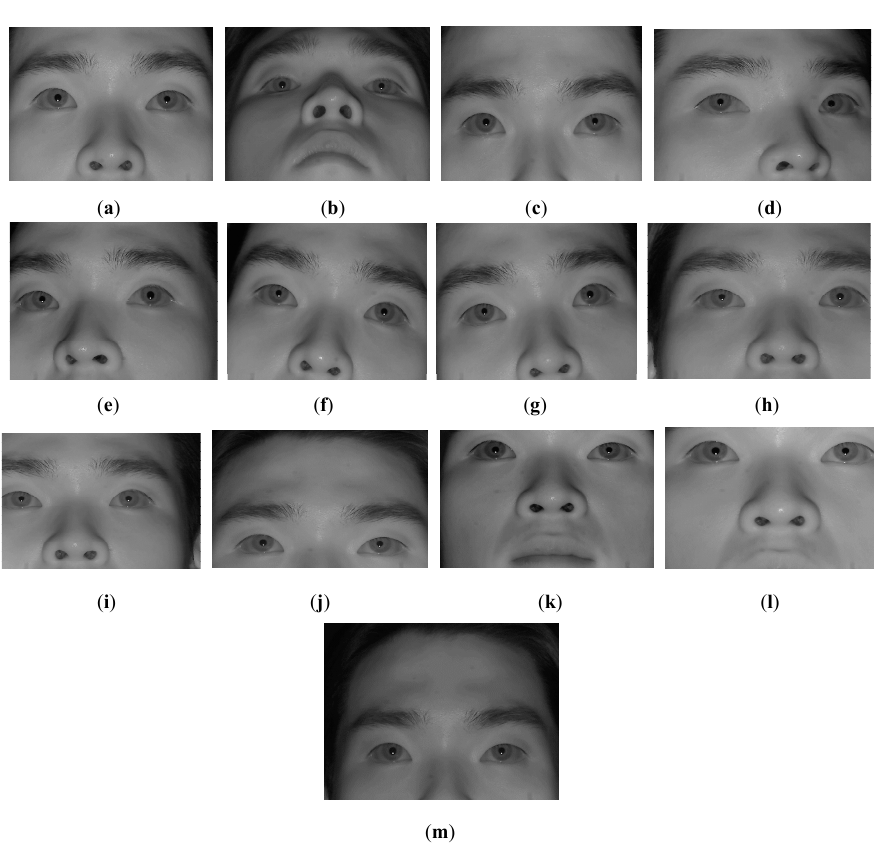
Figure 10. Examples of images according to each head movement: ( a ) No head movement, ( b ) R_X – ,